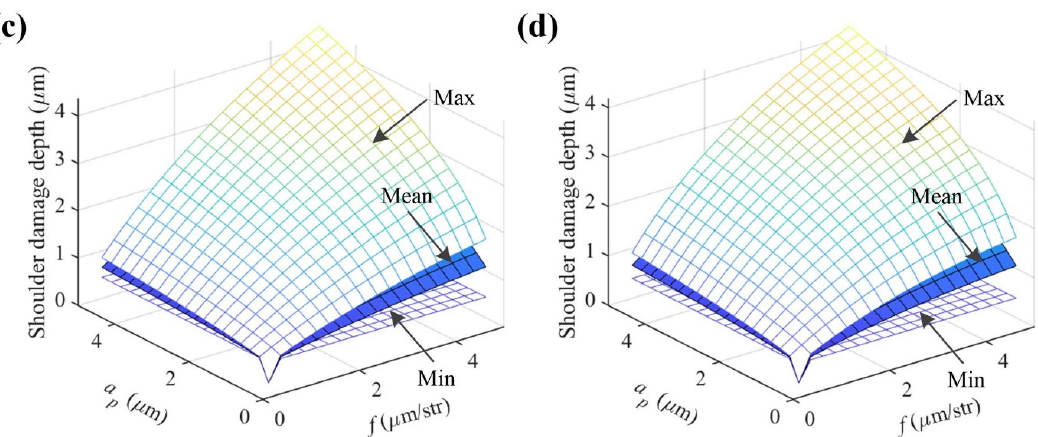
Figure 9. Calculated shoulder damage depths under a broader range of cutting parameters using